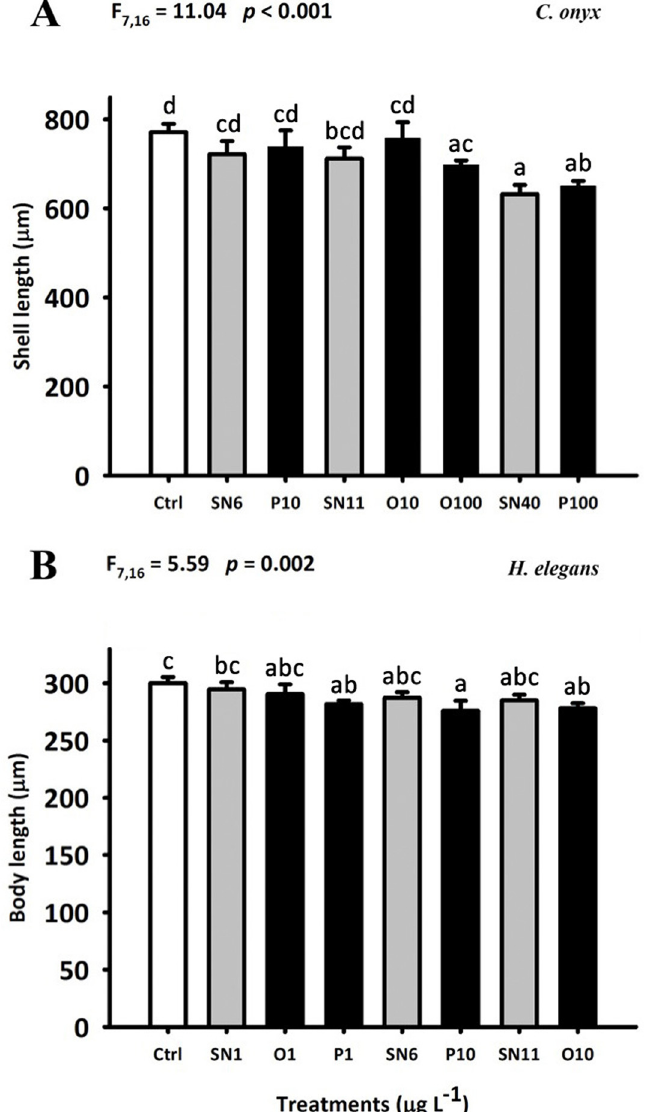
Fig 6. Effect of OAgNPs, PAgNPs and AgNO 3 on the larval growth of C . onyx (A) and H . elegans (B). Each bar represents the mean (+ SD) of three replicates. One-way ANOVA was used for the statistics analysis. Different letters above the bar indicate the means that are significantly different as identified by Tukey ’ s test. Ctrl: FSW control, SN: AgNO 3 , O: OAgNP and P: